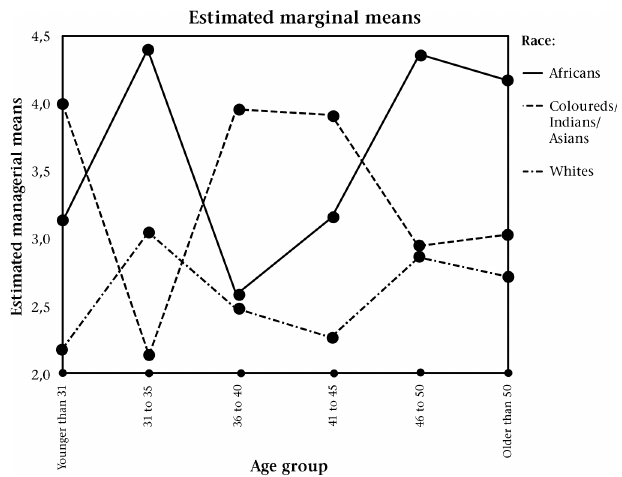
Figure 9: Biographical variables: Age × Race as predictors of the perceptions of black economic empowerment